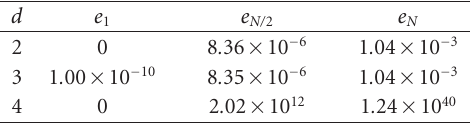
Table 6.3. Approximate error for Example 6.3.